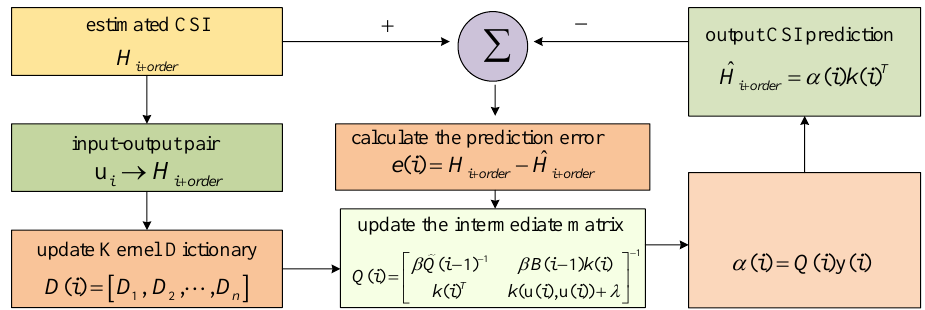
Figure 4. An illustration of the channel prediction algorithm